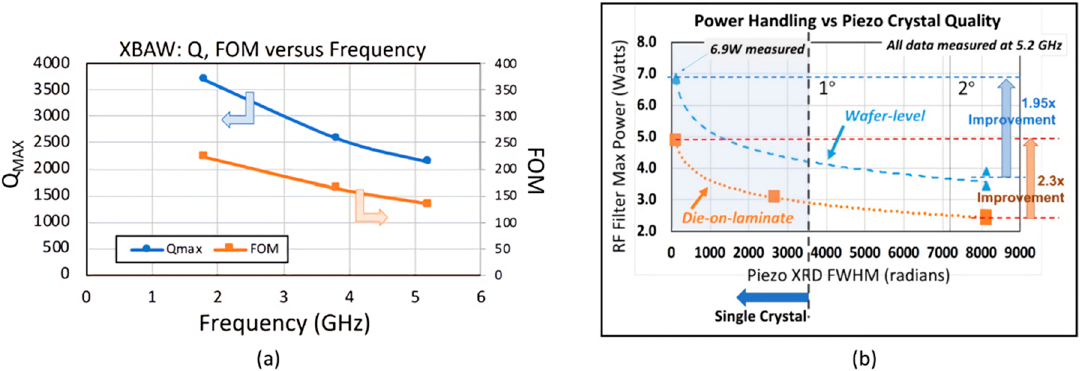
Figure 8. ( a ) Q-value and figure of merit (FOM) as functions of frequency when using XBAR TM (single crystal AlN technology) [43]. ( b ) Measured power level capability of single crystal AlN and poly-crystalline AlN [43]. Reproduced with permission from [43]